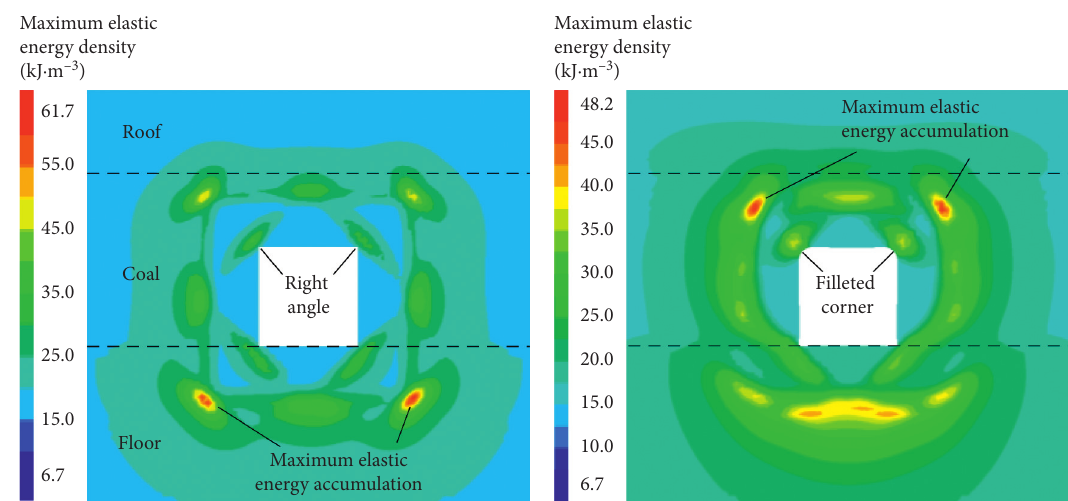
Figure 16: Comparison of maximum elastic energy density.